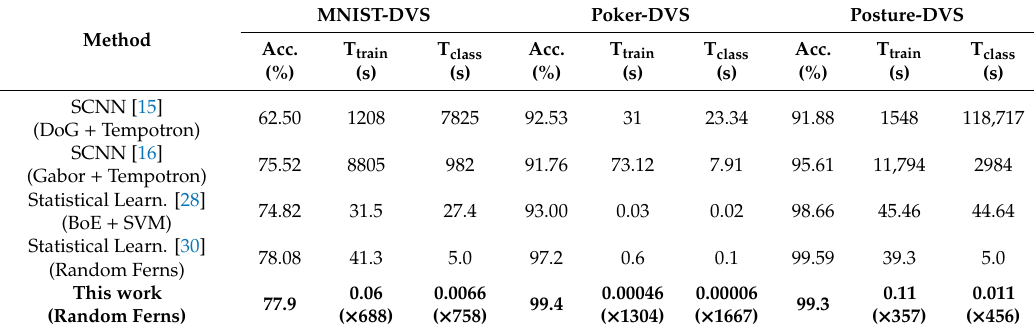
Table 3. Comparison to software-based solutions for AER object